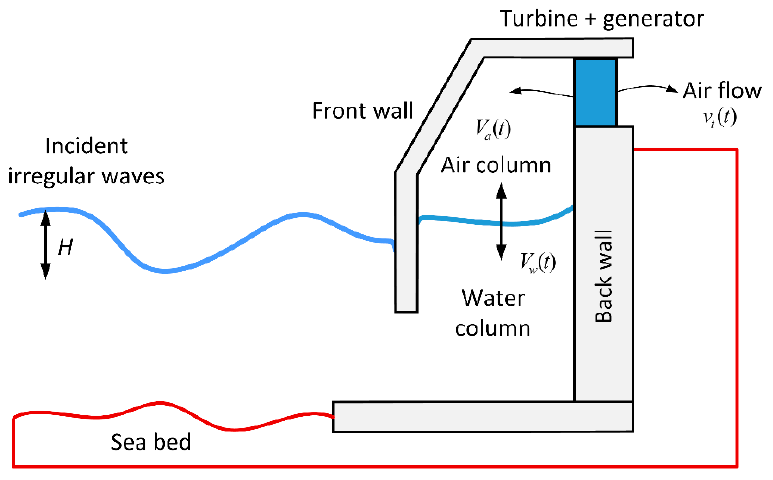
Figure 2. Schematic of the on-shore OWC